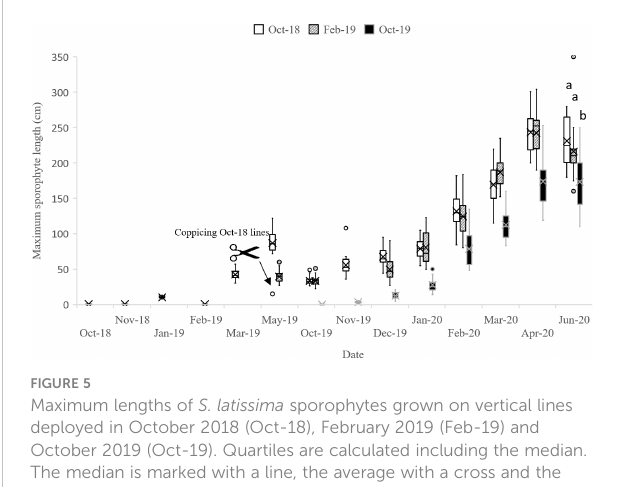
FIGURE 5 Maximum lengths of S. latissima sporophytes grown on vertical lines deployed in October 2018 (Oct-18), February 2019 (Feb-19) and October 2019 (Oct-19). Quartiles are calculated including the median. The median is marked with a line, the average with a cross and the max/min values with whiskers in top/bottom of each box (n = 18-36). The maximum sporophyte length was measured as the six longest sporophytes on each line (n=18-36). Letters indicate signi fi cant differences in length between the different deployments on the fi nal harvest day in June